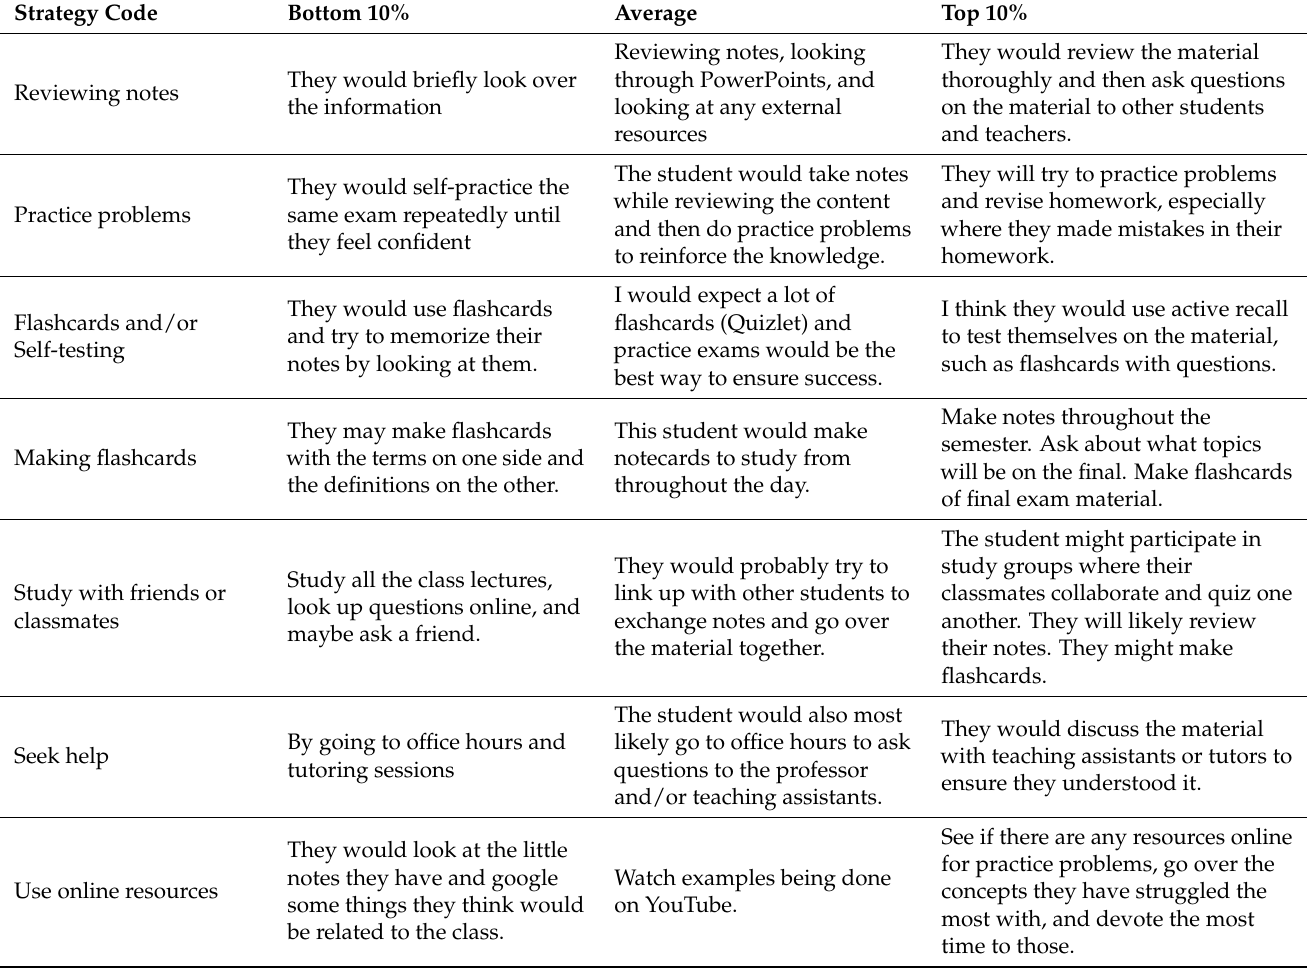
Table 5. Example Responses for Commonly Reported